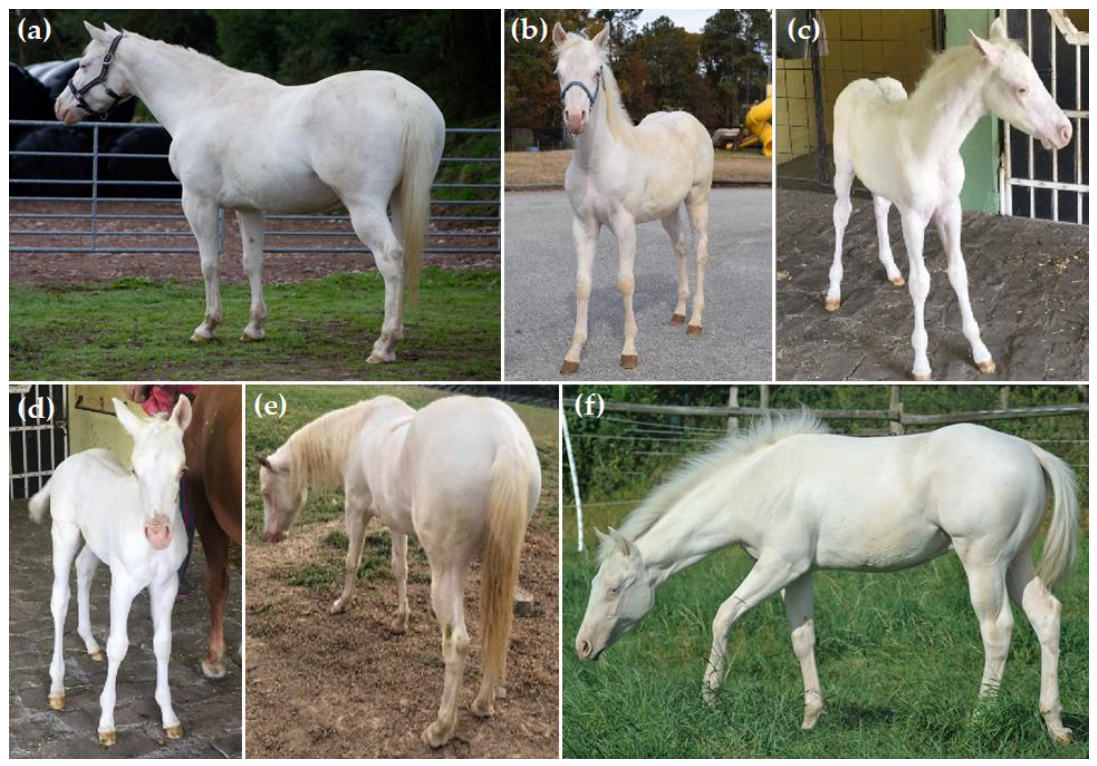
Figure 2. Six Quarter Horses homozygous for the SW2 white patterning allele ( SW2/SW2 ). ( a ) Bay base coat with cream dilution, known as buckskin, ( E/e A/A Cr/N ) and having other white pattern alleles ( SW1/N W20/N ); ( b ) Bay base coat ( E/e A/A ) and other white patterning alleles ( SW1/N W20/N ); ( c ) Bay base coat ( E/e A/A ) and SW1/N W20/N ; ( d ) Bay base coat ( E/e A/a ) and SW1/N W20/N ; ( e ) chestnut base coat with cream allele, known as Palomino ( e/e A/A Cr/N ), with no other dilution or white patterning alleles detected; ( f ) Bay base coat ( E/E A/a ) and homozygous W20/W20 . After removing related individuals, the frequency was low in both breeds (a.f. =